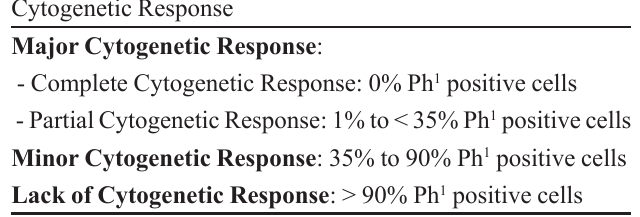
TABLE IV - Criteria for classification of CR (Brasil. Ministério da Saúde, 2001) Cytogenetic Response Major Cytogenetic Response :